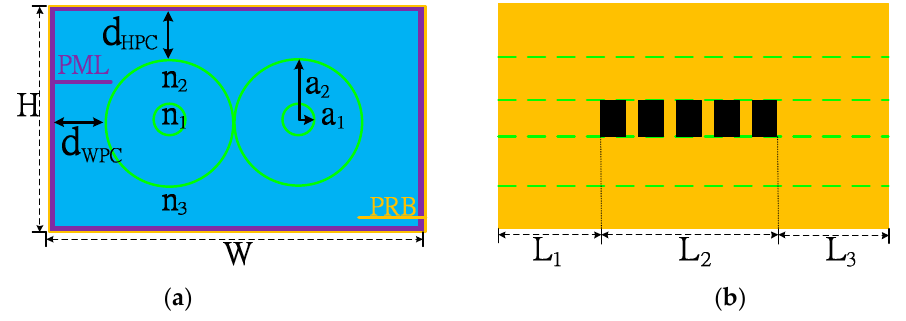
Figure 3. Geometric structure of the FBG-OADM: ( a ) sectional view from the X-Y plane; and ( b ) side view from the Y-Z plane.